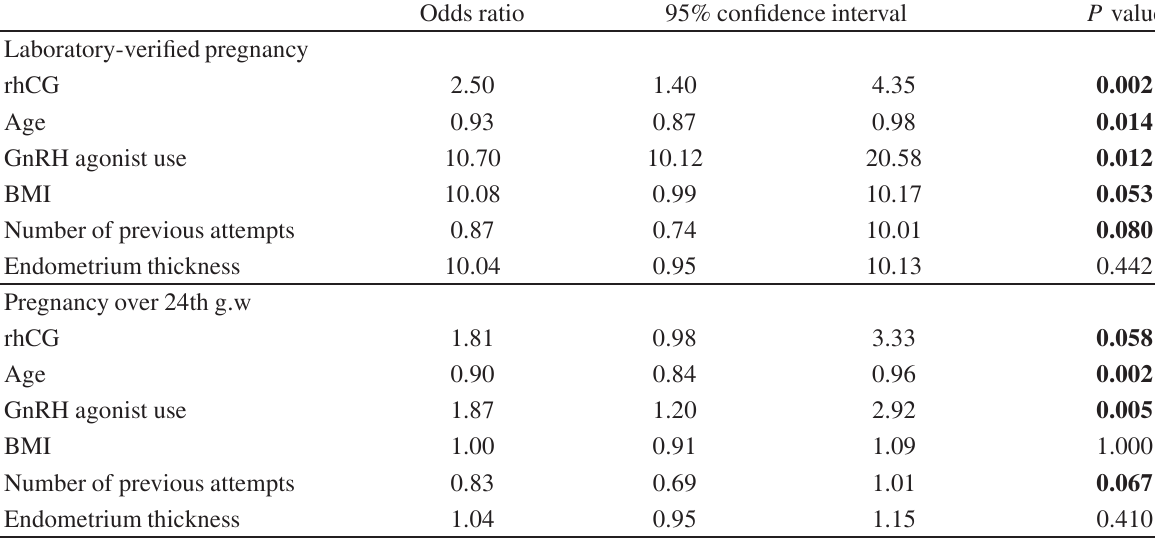
TABLE 2: The impact of rhCG/uHCG use and clinical characteristics on the occurrence of laboratory-verified pregnancy and pregnancy over 24th week of gestation. Results of logistic regression analysis.